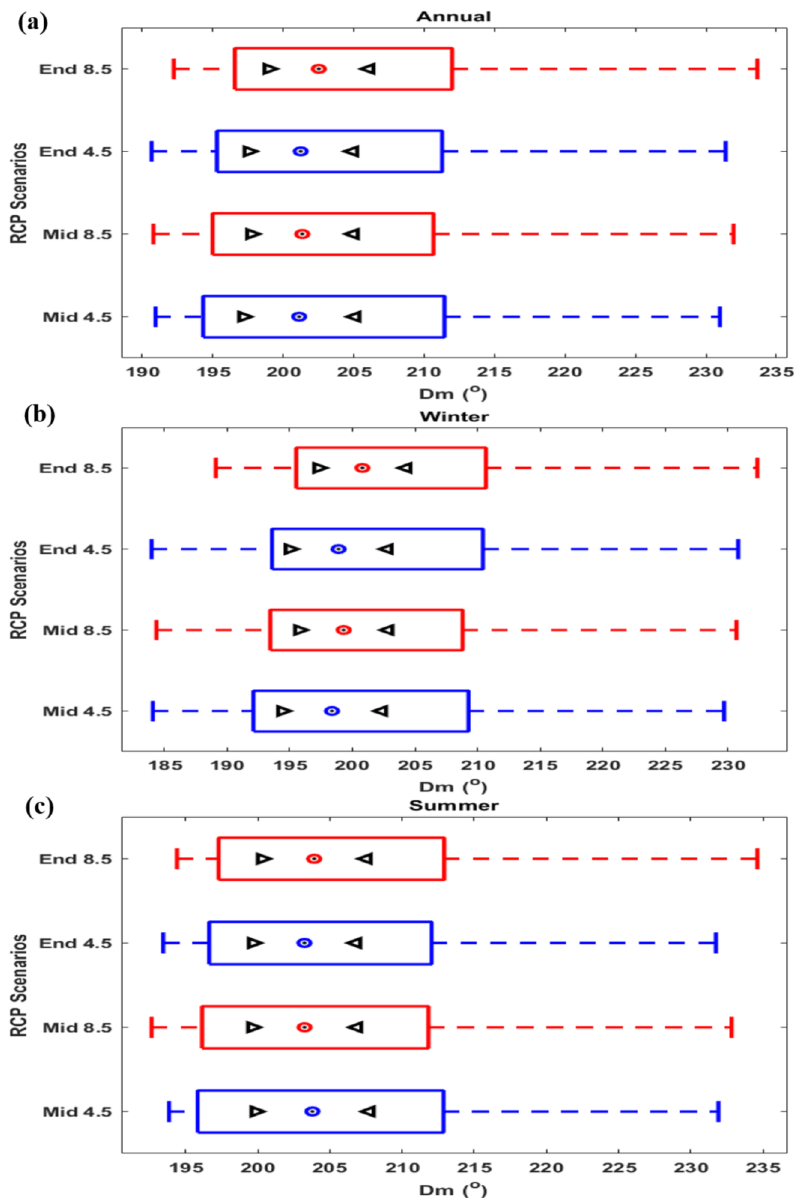
Figure 13. Boxplots showing the overlaps between Hs means for all future RCP scenarios with blue and red boxplots representing the RCP 4.5 and RCP 8.5, respectively for ( a ) annual ( b ) winter ( c ) summer.